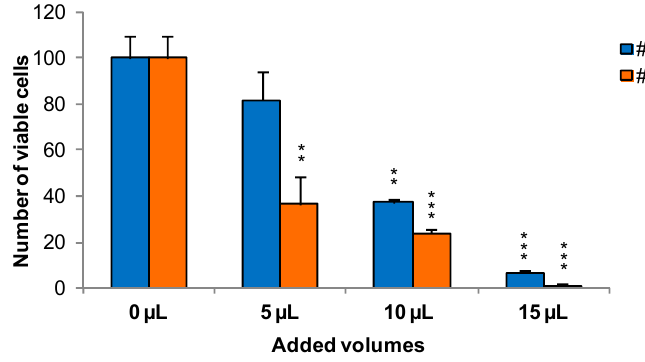
Figure 1. Twenty-four hours of incubation with increasing amounts of extracts #46 and #57 arrest the growth of MCF-7 cells in a concentration dependent manner ( p values: ** < 0.01; *** < 0.001).